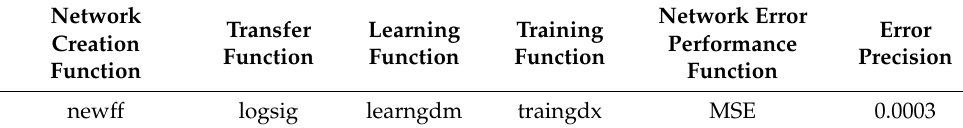
Table 8. BP network model